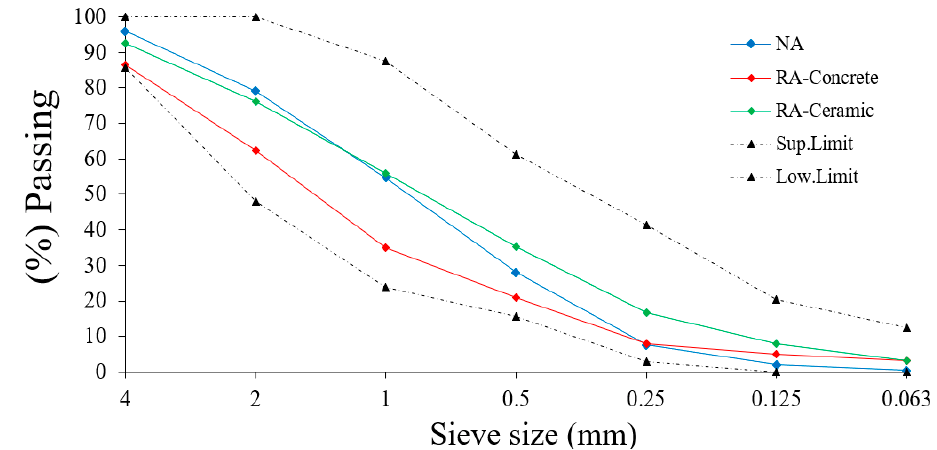
Figure 3. Recycled aggregate size distribution curve compared to the limits of NBE.FL 90 [49] adapted to the sieve size established by UNE ‐ EN ‐ 933 ‐ 2 [48].